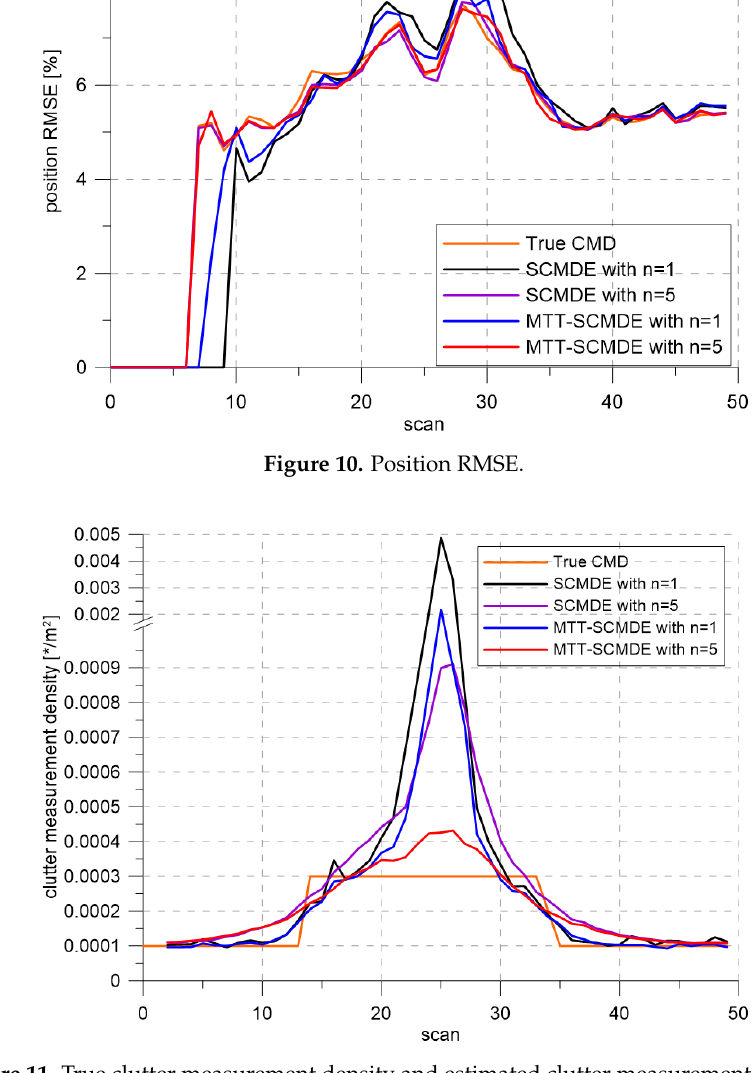
Figure 11. True clutter measurement density and estimated clutter measurement density. Table 2. Track retention statistics for Monte Carlo